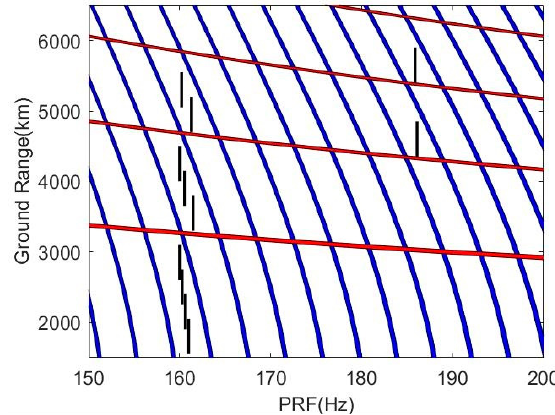
Figure 2. Timing diagram selection result of the monostatic geostationary synthetic aperture radar (GEO SAR) with a swath width of 500 km.